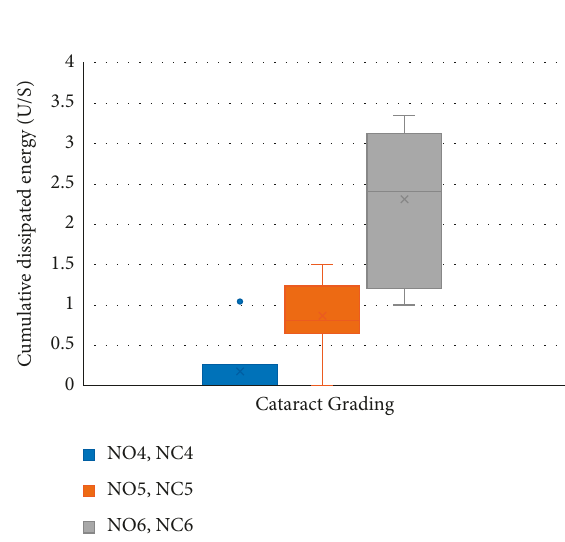
Figure 1: The box and whisker plot showing correlation between different cataract grades and the mean cumulative dissipated en- ergy used (NO: nuclear opalescence; NC: nuclear color).